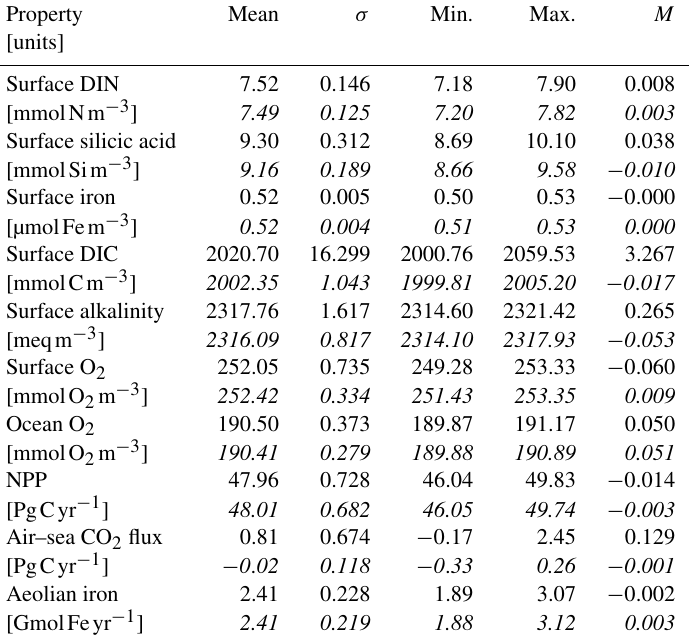
Table 2. Selected ocean biogeochemical properties averaged across both the historical ensemble (upper rows) and corresponding segments of the piControl (lower italicized rows). For each property, the statistics refer to the full 165-year period from 1850 to 2015. The final statistic, M , is the linear slope of the change in the property across this full